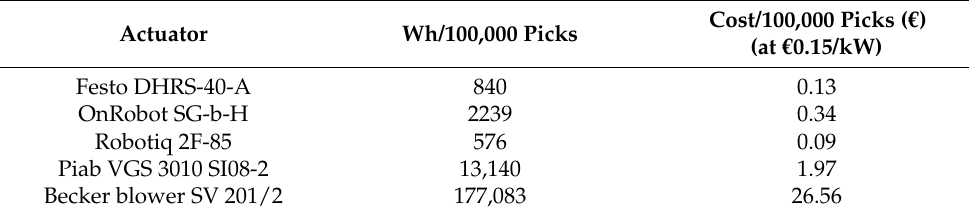
Table 1. Results of the power consumption